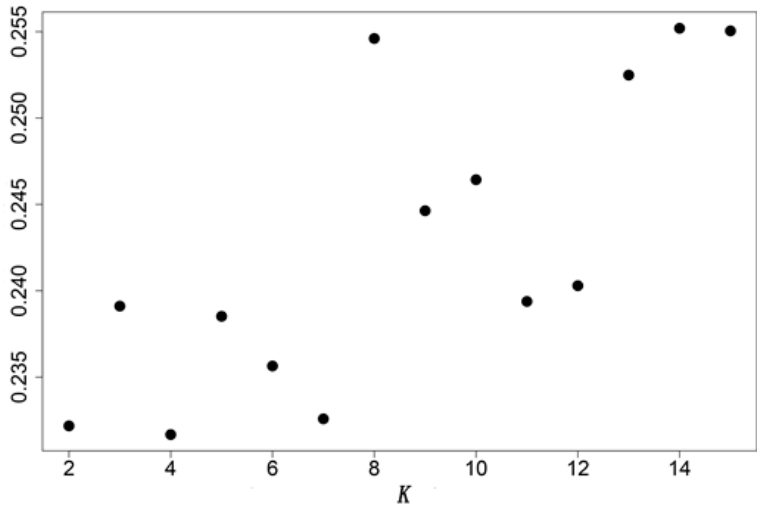
Figure 5. Cross-entropy at different values of number of genetic cluster ( K ).